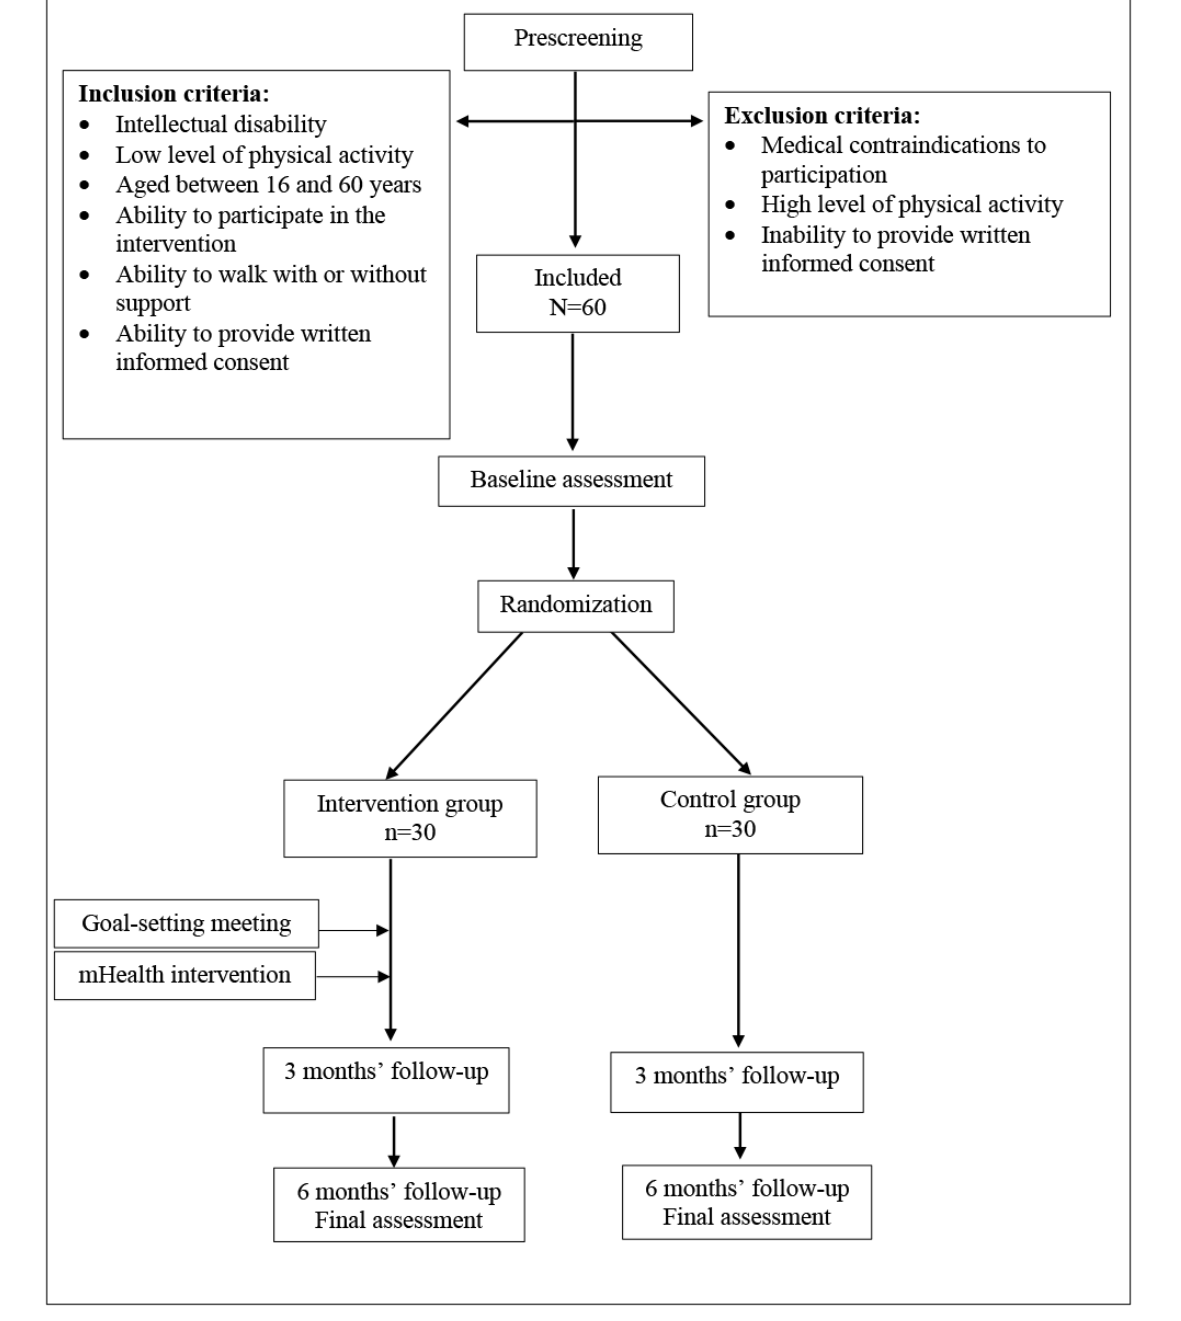
Figure 3. Consolidated Standards of Reporting Trials flow diagram of the study. mHealth: mobile